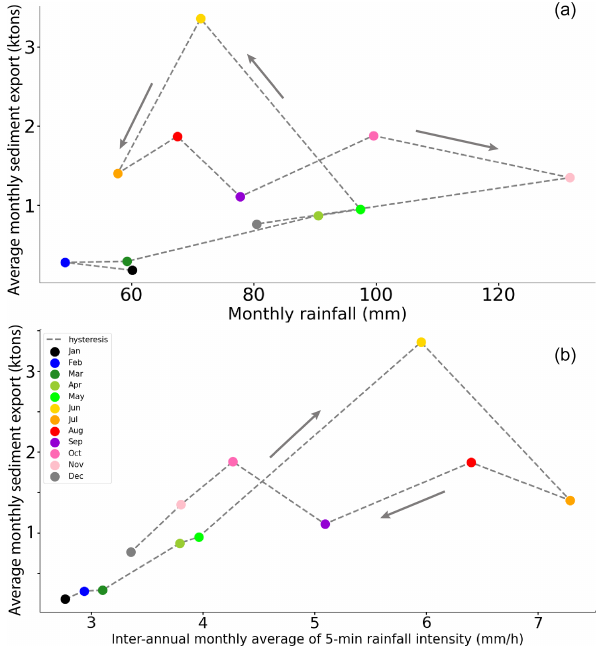
Figure 4. Hysteresis plot using interannual monthly average val- ues from the Laval catchment between 2003 and 2020. (a) Monthly sediment export (kt) versus monthly rainfall. The dashed line high- lights the hysteresis cycle with two separate maxima: high sedi- ment export and moderate rainfall in June versus high total rainfall and moderate sediment export in October–November. (b) Monthly sediment export (kt) versus monthly average rainfall intensity. The dashed line illustrate the hysteresis cycle with a maximum of sedi- ment export in June preceding a stationary period with around 1.5kt of sediment export per month between July and November. A plot of all monthly rainfall averages is shown in Fig. S4.